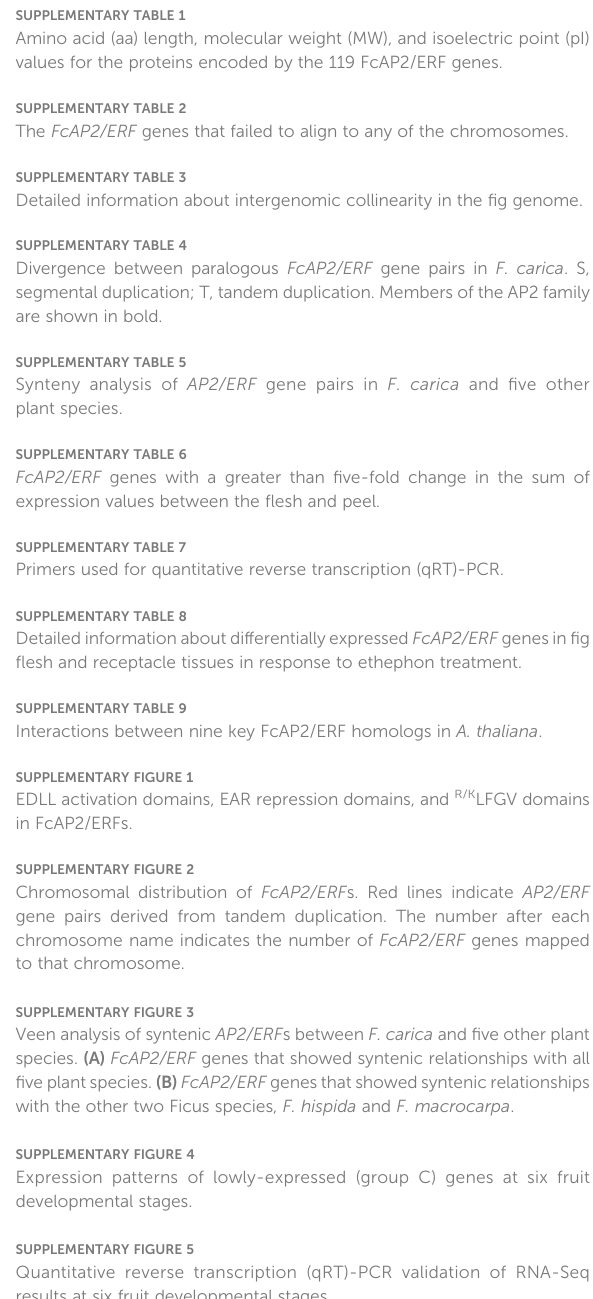
SUPPLEMENTARY FIGURE 1 EDLL activation domains, EAR repression domains, and R/K LFGV domains in FcAP2/ERFs.